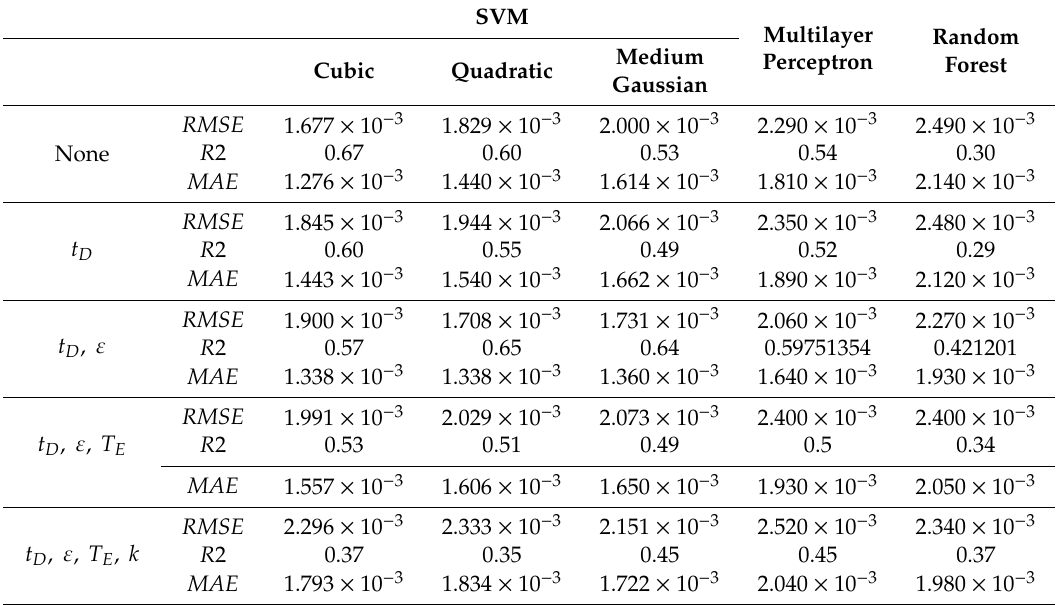
Table 8. Performance results for defect length predictor models using a dataset of 500 sets of values. Part 2: SVM, MLP, and RF when “Contrast Rear” is not contemplated as feature.